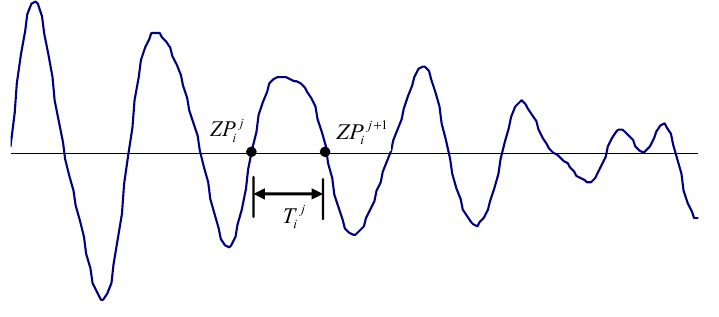
Figure 1. Illustration of zero-crossings and IHP model defined in this